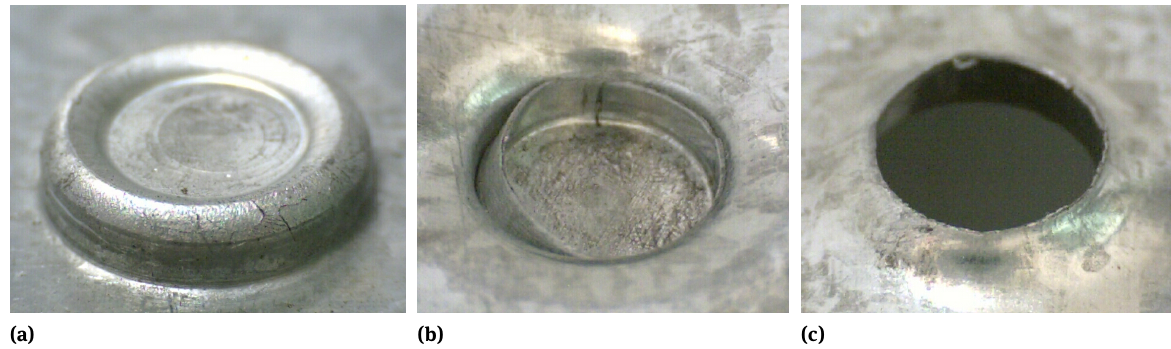
Figure 7: Clinched joint with DX53 sheets after tensile test: (a) bottom sheet, (b) middle sheet, (c) top sheet.